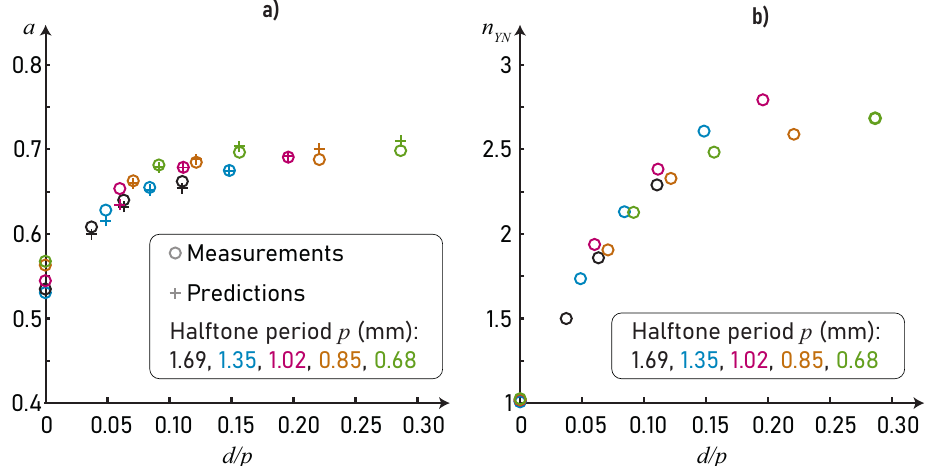
Figure 8. ( a ) Apparent surface coverage estimated with the Murray–Davies equation; ( b ) fitted n YN parameter of the Yule–Nielsen